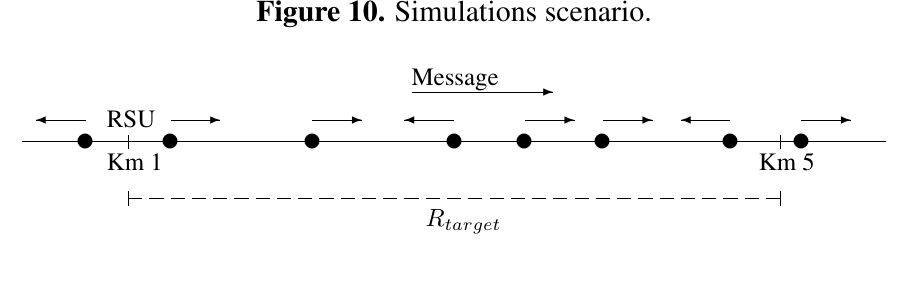
Figure 10. Simulations scenario.